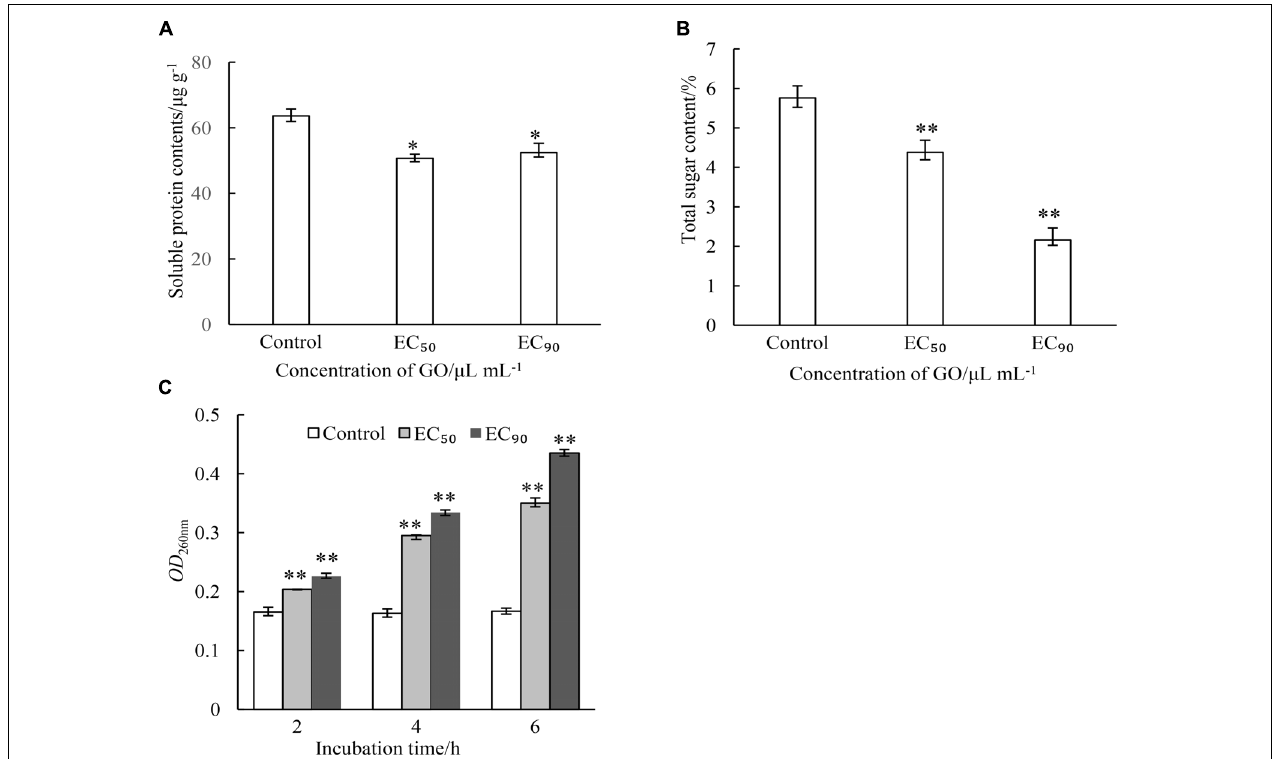
FIGURE 4 | Effects of different concentrations of GO on leakage of proteins (A) , leakage of total sugars (B) and leakage of nuclein (C) of P. microspora . Each value is the mean for three replicates. The vertical bar indicates the standard error. The asterisks indicate significant difference between control and GO treated fruit ( ∗∗ P < 0.01, ∗ P < 0.05).